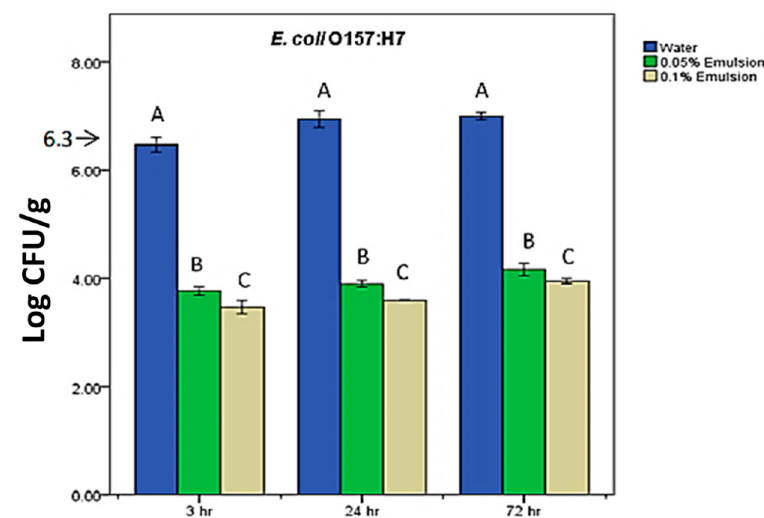
Figure 6. Inhibition of Escherichia coli on fresh lettuce by oregano oil NEs. Reproduced with permission from Noori et al., Food Control, Published by Elsevier, 2018 [110].